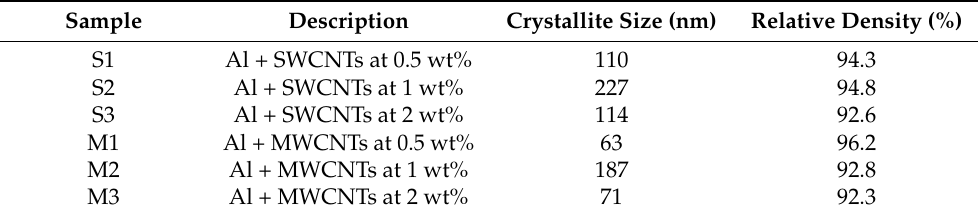
Table 2. Crystallite size and relative density of Al-based CNT nanocomposites with different wt% of